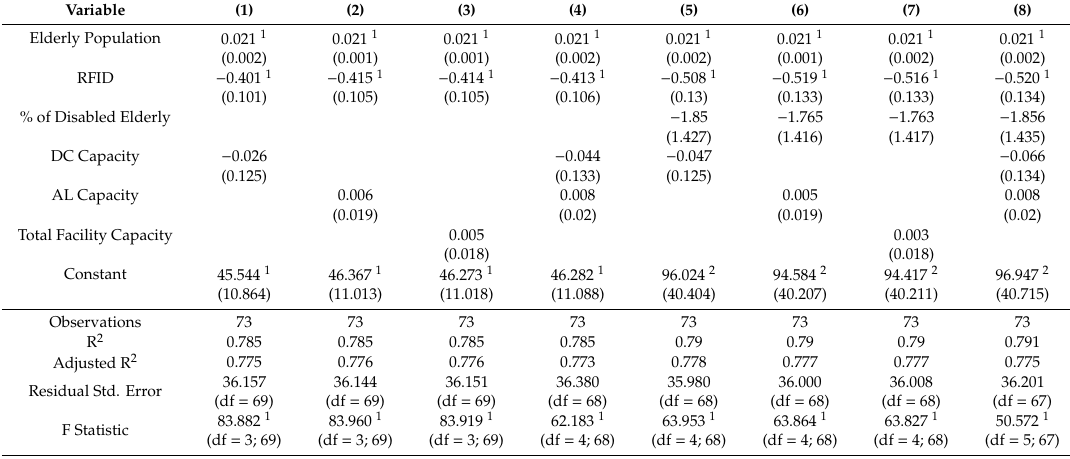
Table 4. Regression analysis for the number of confirmed cases of COVID-19 in Barcelona by neighborhood until 20 July 2020 (standard errors are displayed in parenthesis under the coe ffi cient estimates, n = 73